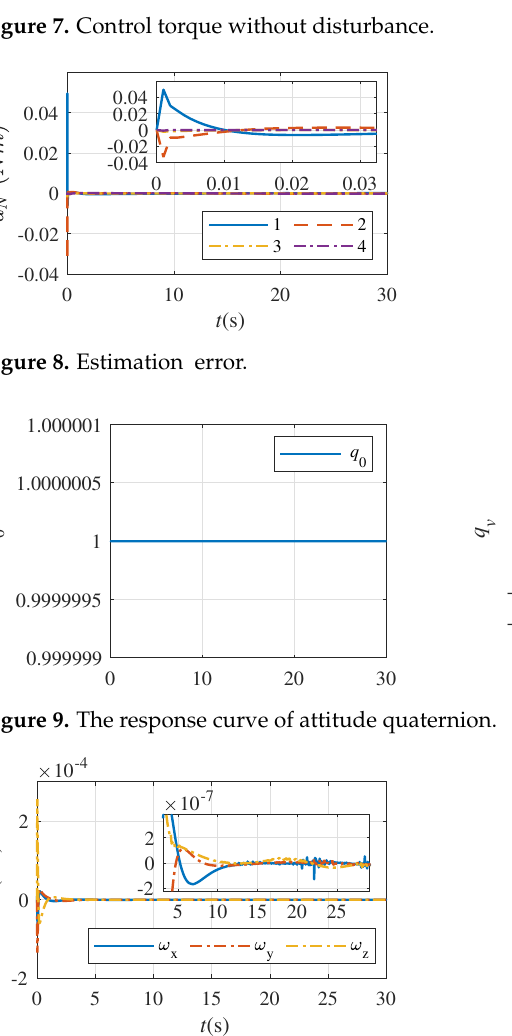
Figure 10. Angular velocity of spacecraft.